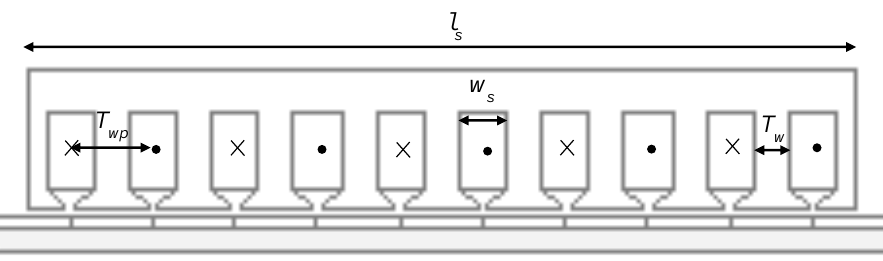
Figure 7. Tooth Width, T w Variation.